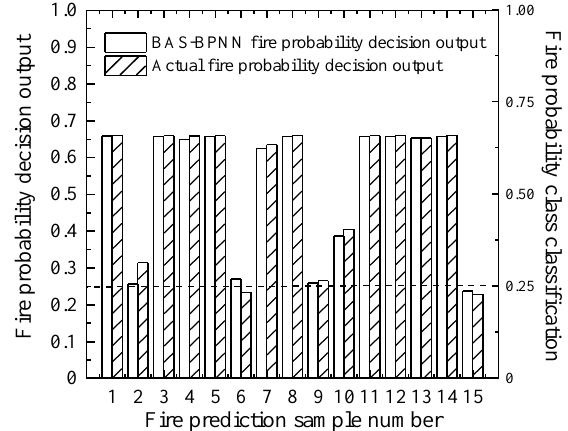
Figure 11. Fire decision output classification.